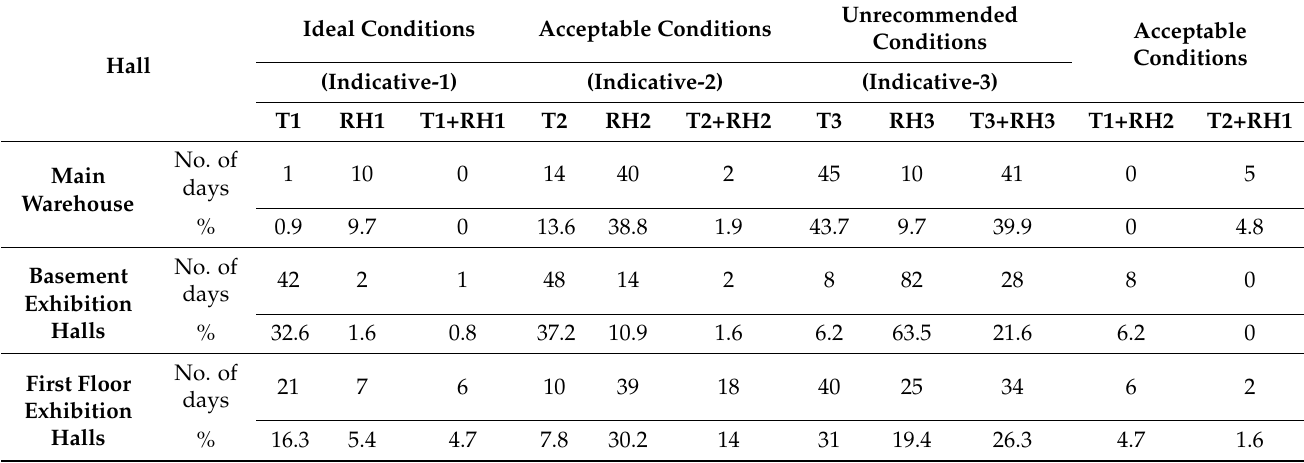
Table 2. The quality of indoor microclimate expressed by the number of days in which the temperature and RH have recorded ideal/acceptable/not recommended values according to the standards in force (T-1, RH-1—days when only temperature or RH have recorded ideal values; T-2, RH-2—days when only temperature or RH have recorded acceptable values; T-3, RH-3—days when only temperature or RH have recorded not recommended values; T+RH-1—days when both temperature and RH have recorded ideal values; T+RH-2—days when both temperature and RH have recorded acceptable values; T+RH-3—days when both temperature and RH have recorded not recommended values; T1+RH2, T2+RH1—days when ideal situations at an indicator mixed with the acceptable ones at the other indicator).